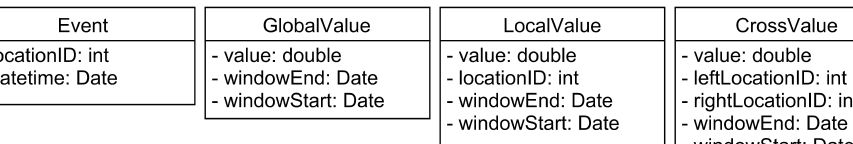
Figure 4. UML class diagram of the defined data